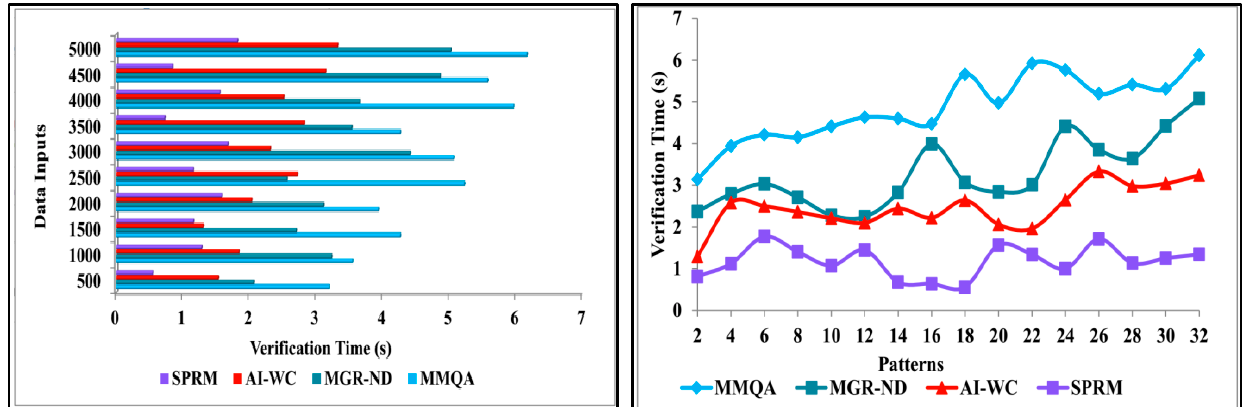
Figure 14. Verification time analysis.